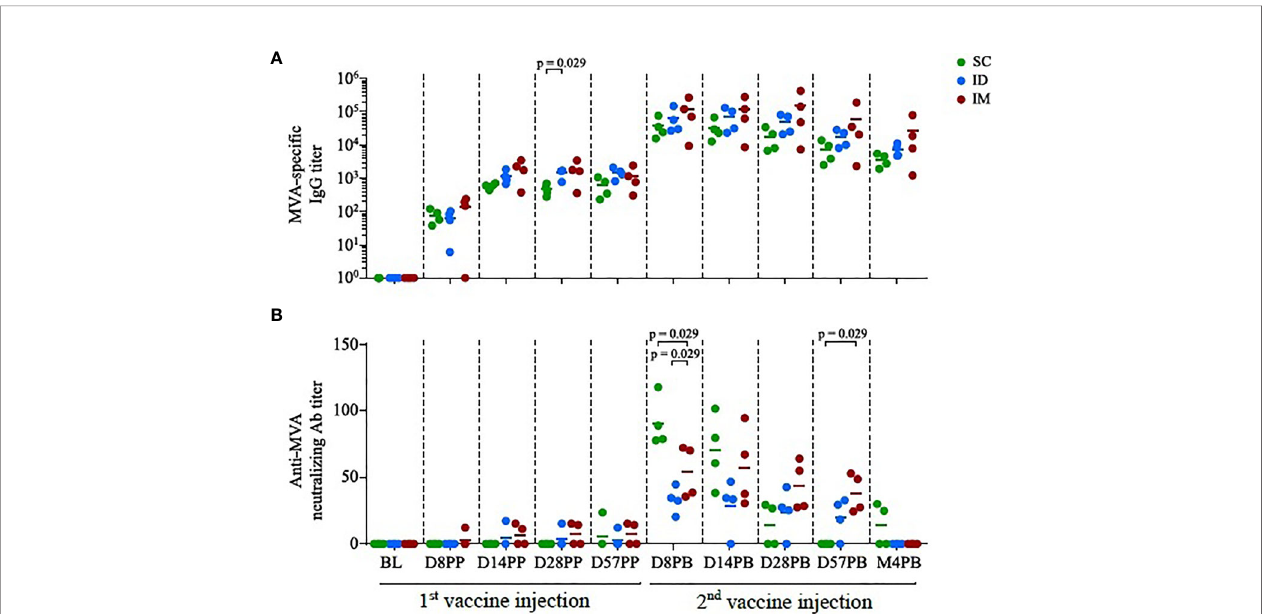
FIGURE 1 | Antibody responses induced by homologous MVA prime-boost administered by the SC/ID/IM routes. (A) Scatter plot of MVA-speci fi c IgG titers over time, characterized by ELISA. Each dot corresponds to one single biological sample. The colors correspond to the different administration routes. (B) Scatter plot of MVA neutralization titers over time, characterized by plaque reduction assay. Each dot corresponds to one single biological sample. BL, baseline; D, day; PP, post- prime; PB, post-boost; M,